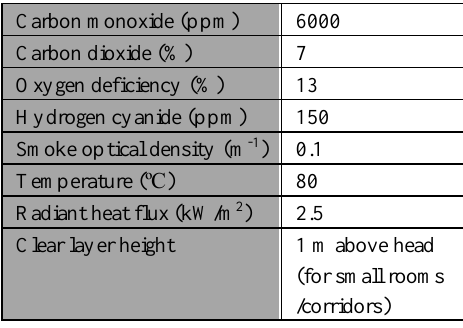
Table 2. Stamina limits in smokey environment.